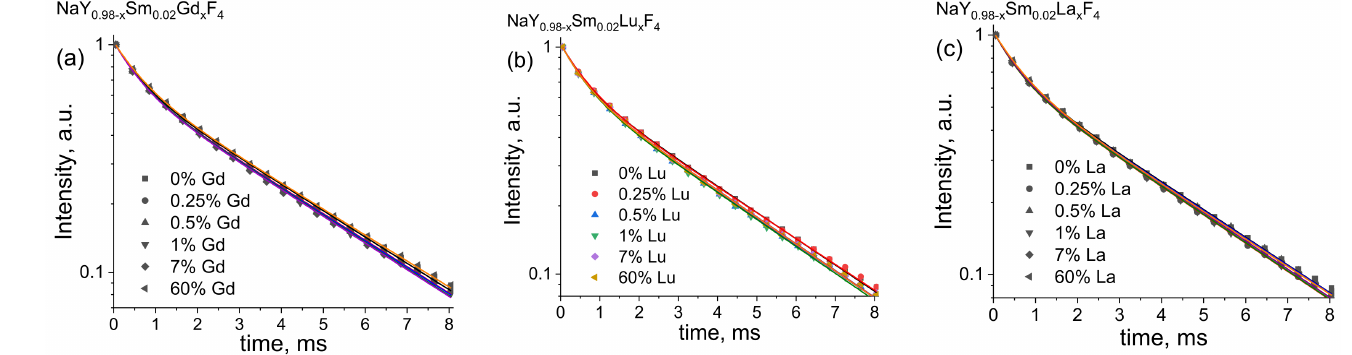
Figure 11. Luminescence decay curves of NaY 0.98 − x Sm 0.02 Ln x F 4 (Ln = Gd, Lu, La on the panels ( a – c ), respectively), phosphors monitored at 595 nm upon 400 nm excitation. Experimental values and best biexponential fits are shown as dots and lines,